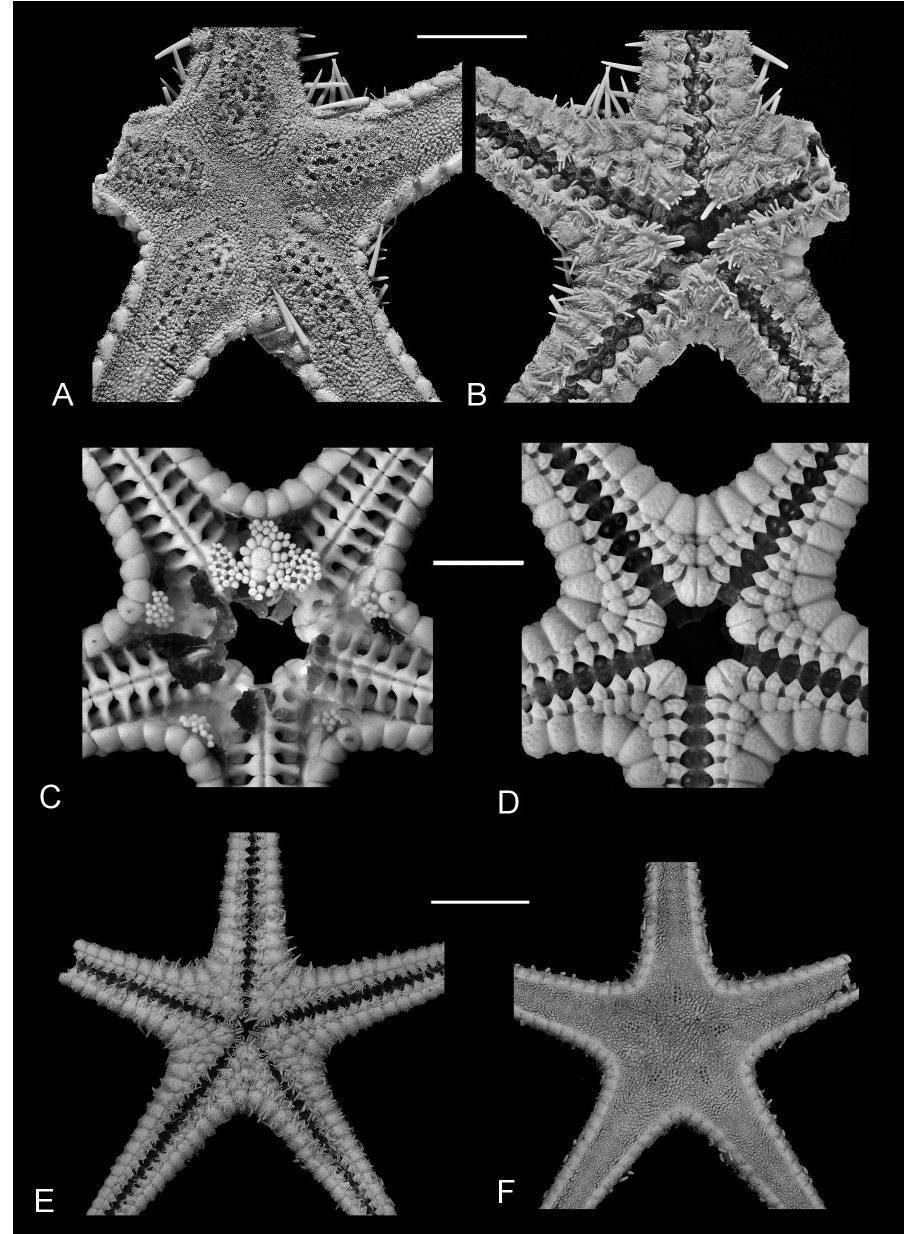
Fig. 1. A–B . Cheiraster gazellae Studer, 1883, Recent, in abactinal (A) and actinal (B) views (A.S. Gale collection, unregistered). C–F . Pontaster tenuispinus (von Düben & Koren, 1846), Recent, in various views (A.S. Gale collection, unregistered), Rockall Trough, NE Atlantic. Scale bars: A–B = 7 mm; C–D = 5 mm; E–F = 10